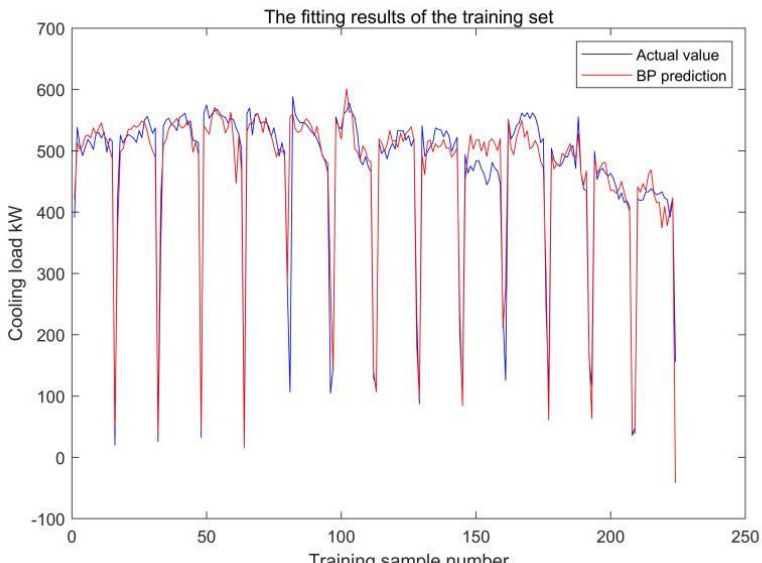
Figure 18. Fitting effect of the training set. Figure 19 represents the absolute error of the predicted values of the training set 1 h ahead. From the figure, it can be seen that the absolute errors of the vast majority of the 224 training samples are kept within 60 kW, and only very few data have absolute errors exceeding 100 kW.